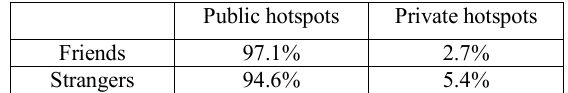
Table 2. Proportion of friends and strangers making contact in public and private hotspots